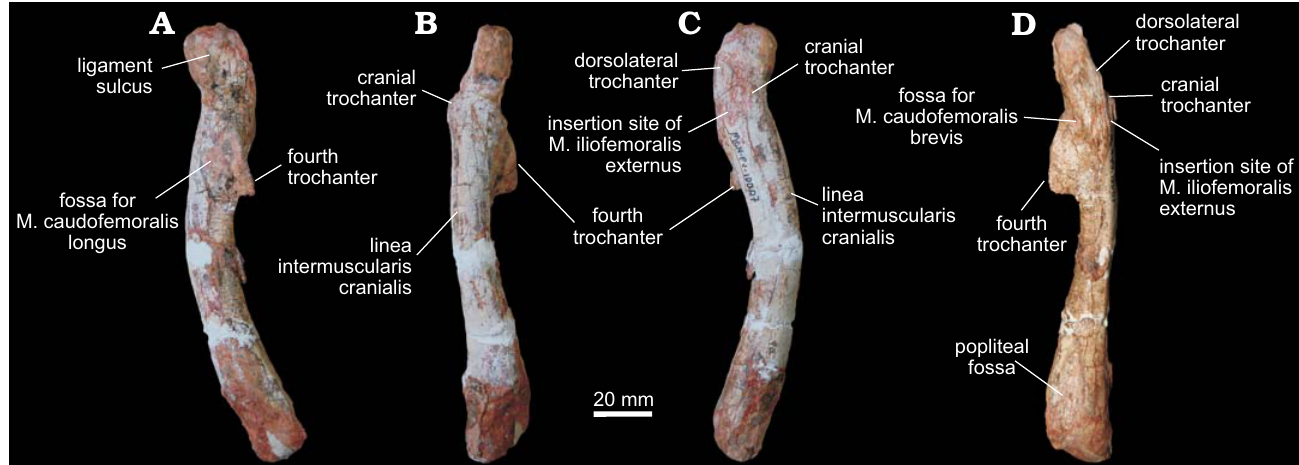
Fig. 5. Left femur of a sauropodomorph from Sacisaurus site, Late Triassic Caturrita Formation, Agudo, Rio Grande do Sul, Brazil; MCN PV10008 in medial ( A ), cranial ( B ), lateral ( C ), and caudal ( D ) views. The head fragment in articulation with the rest of the bone in craniolateral ( E ) and caudomedial ( F ) views. Abbreviation: M., muscle.